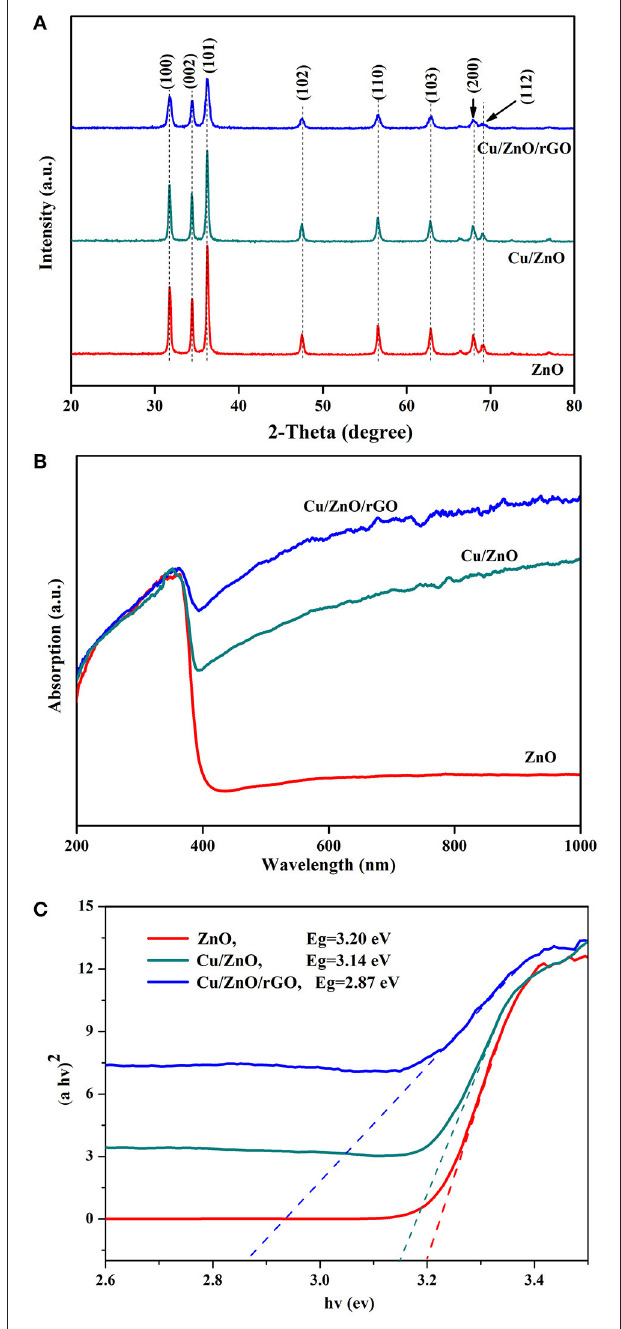
FIGURE 3 | (A) XRD patterns of samples, (B) UV-Vis diffuse reflectance spectra of samples, and (C) Tauc’s plots for ZnO, Cu/ZnO, and Cu/ZnO/rGO.